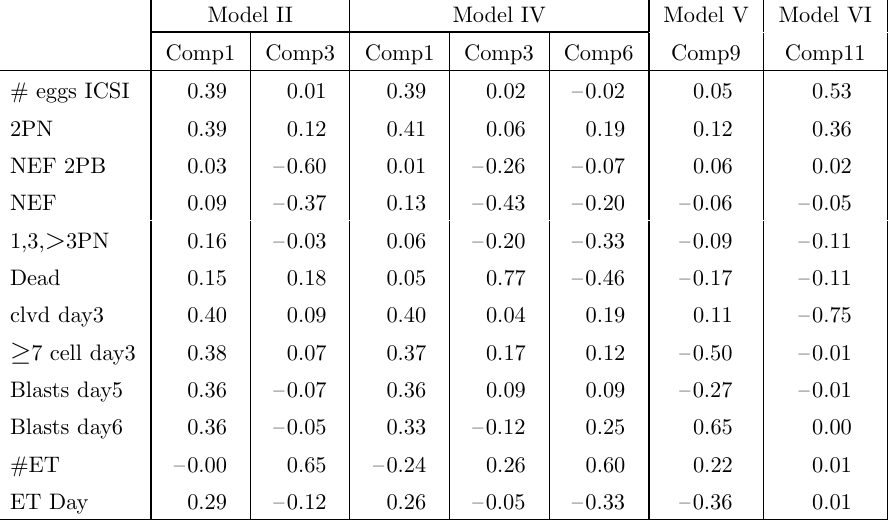
Table 5. Selected components obtained with PCA analysis for the models II, IV, V and VI Model II Model IV Model V Model